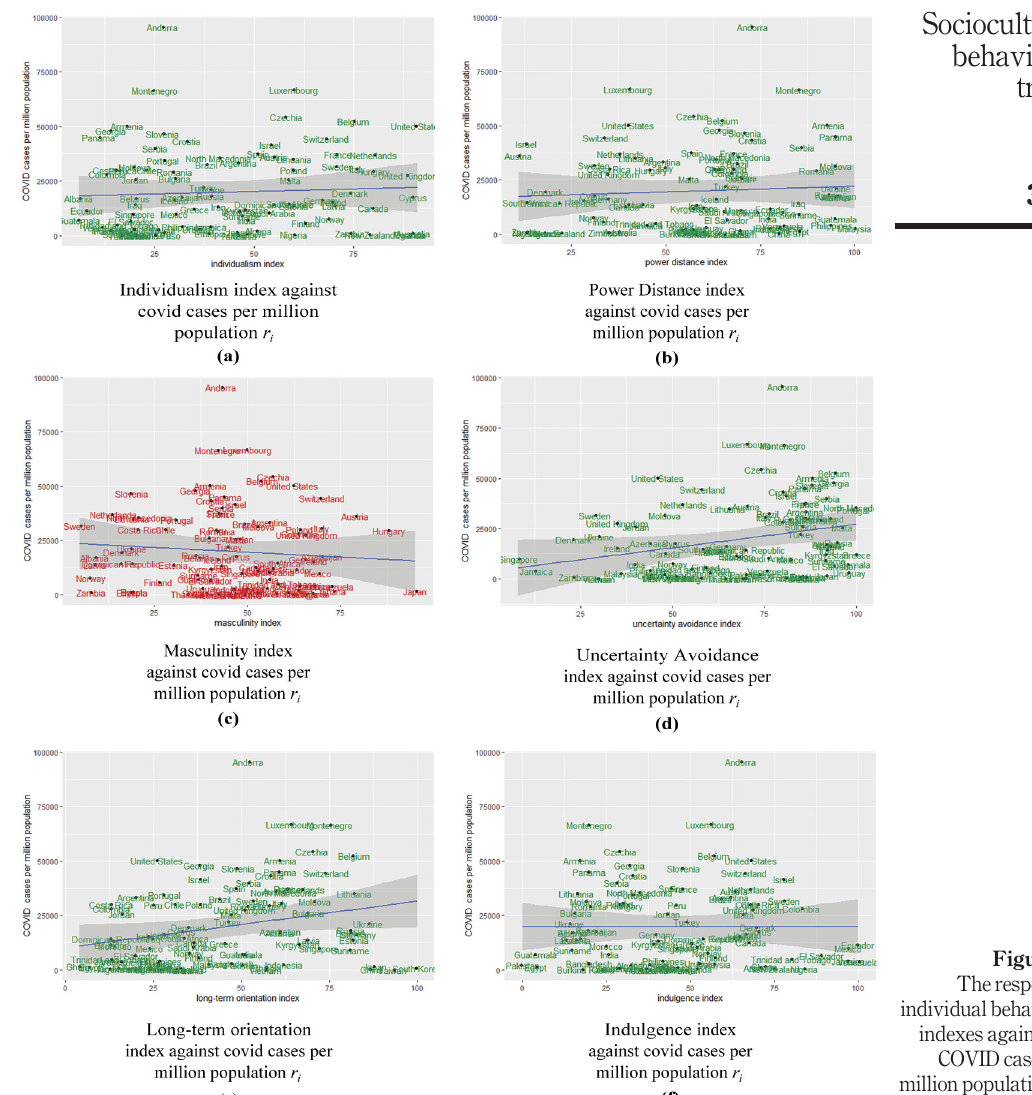
Figure 3. The respective individual behavioral indexes against the COVID cases per million population ( r i